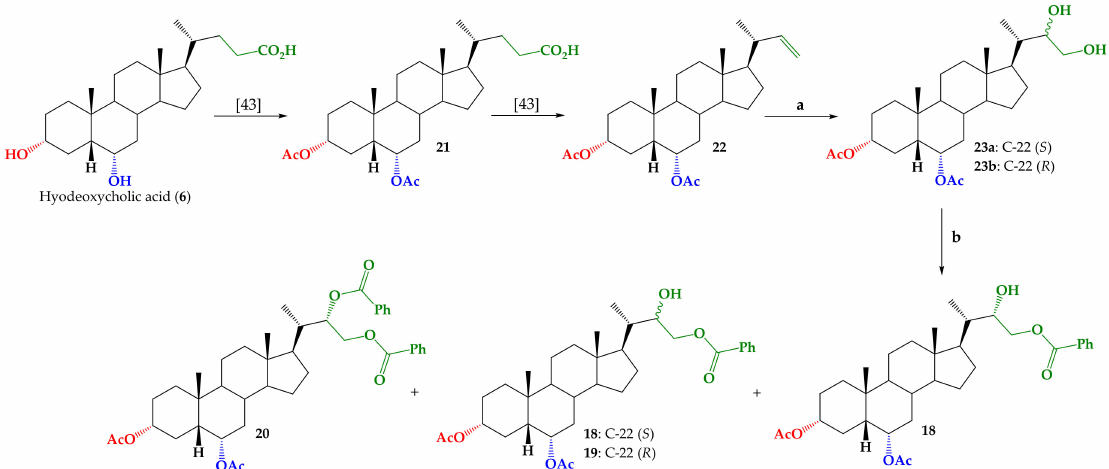
Scheme 1. Synthesis of BR 24-nor-5 β -cholane type analogs with function 23-benzoate 18 – 20 . Reagents and conditions: first two steps are described in Ref. [43] ( a ) DHQD-CLB/CH 3 SO 2 NH 2 , K 2 CO 3 /K3[Fe(CN) 6 ], OsO 4 /(CH 3 ) 3 COH/H 2 O, r.t, 1.5 h 23a / 23b (1.0:0.7), 95% yield; ( b ) C 6 H 5 COCl/DMAP/CH 2 Cl 2 /py, r.t, 36 h, 18 (11.3% yield), 18 / 19 (1.0:0.44, 78.2% yield), 20 (9.1% yield).